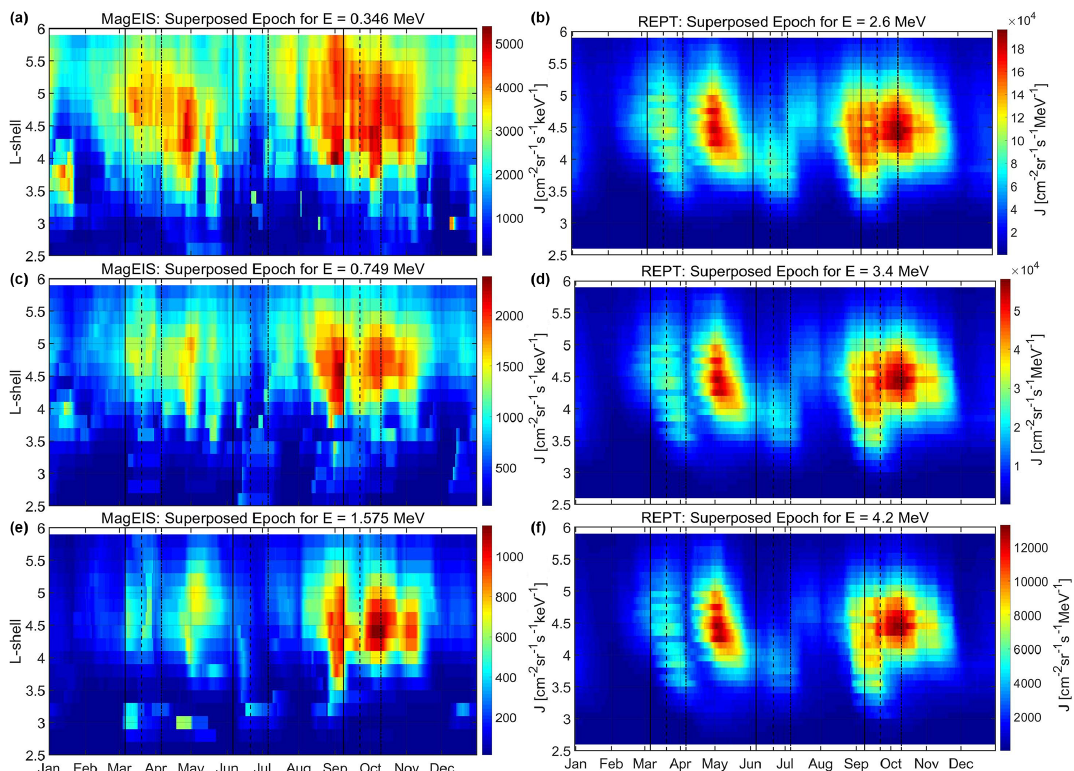
Figure 2. Annual superposed epoch analysis showing 28d moving average of electron fluxes (2013–2019) during the late maximum and descending phase of SC24. Panels (a, c, e) correspond to MagEIS channels (top to bottom: 0.346, 0.749 and 1.575MeV) and panels (b, d, f) to REPT channels (top to bottom: 2.6, 3.4 and 4.2MeV). Similar to Fig. 1, the vertical lines correspond to the equinoxes’ maxima and the summer solstice minimum predicted by the three mechanisms (Cliver et al., 2002).